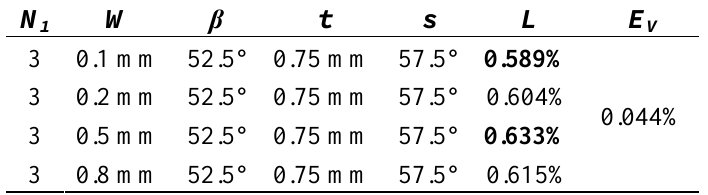
Table 5. Nonlinearity errors of the sensor with different coil widths.